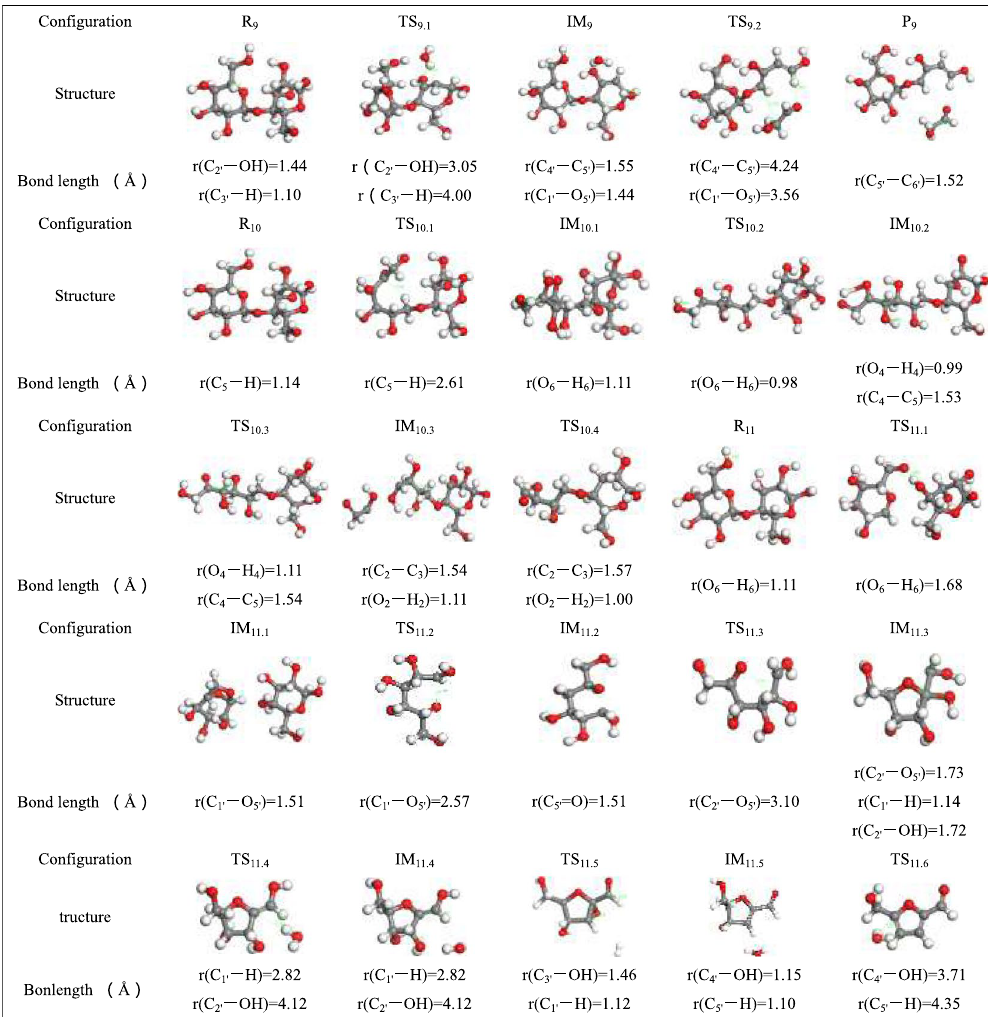
Table 7. Optimized configuration in pathway